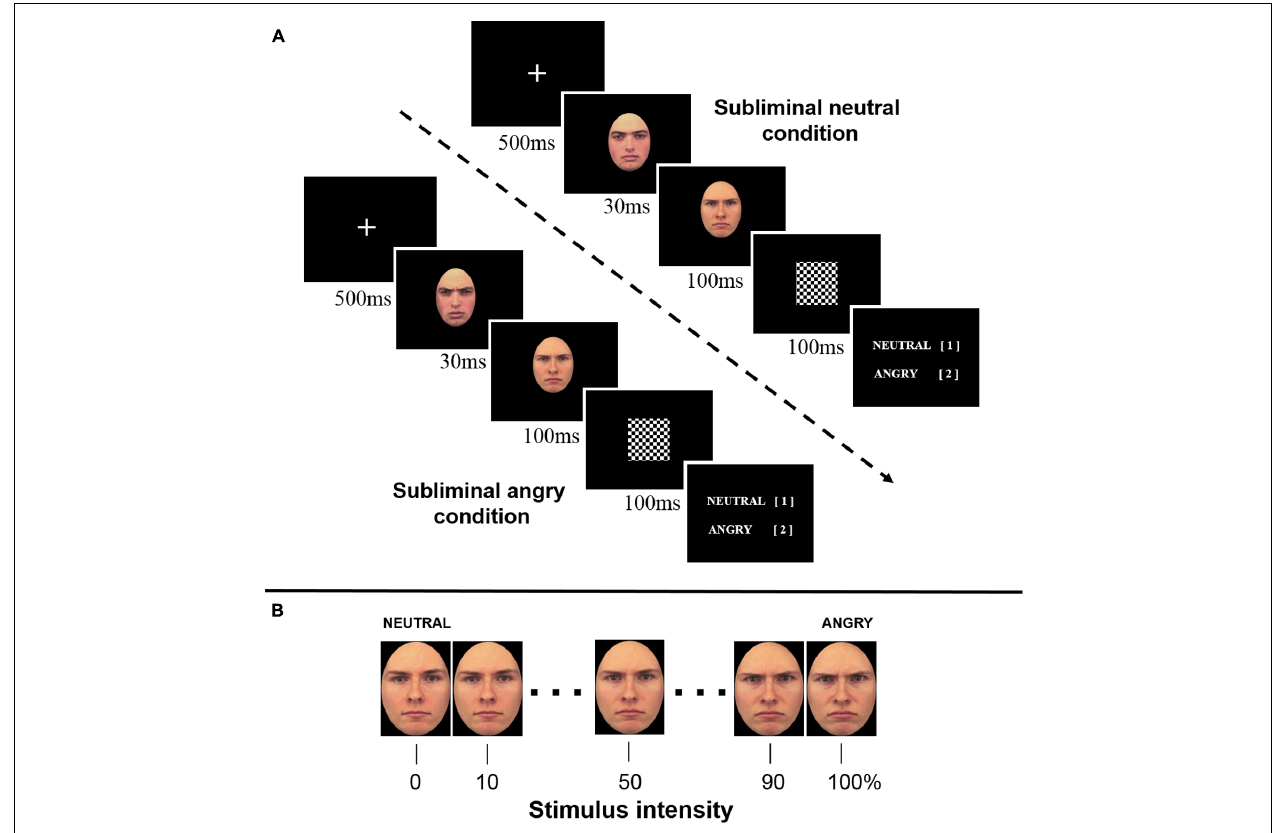
FIGURE 1 | (A) Temporal trial structure for the perceptual decision task. (B) A stimulus set of one model identity parametrically varied in 10% increments ranging from neutral to